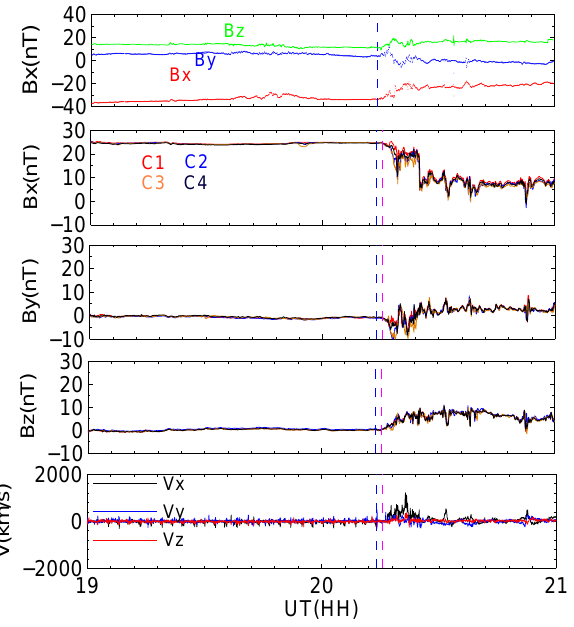
Fig. 6. Magnetotail observations of TC-1 and Cluster. In the top panel are shown B x , B y , B z in GSM coordinates observed by TC- 1, below magnetic field readings of the Cluster quartet and hot ion velocity observed by Cluster-1. The vertical blue dashed line de- notes the substorm onset and red, 1.44min later, the time of field dipolarization at Cluster.